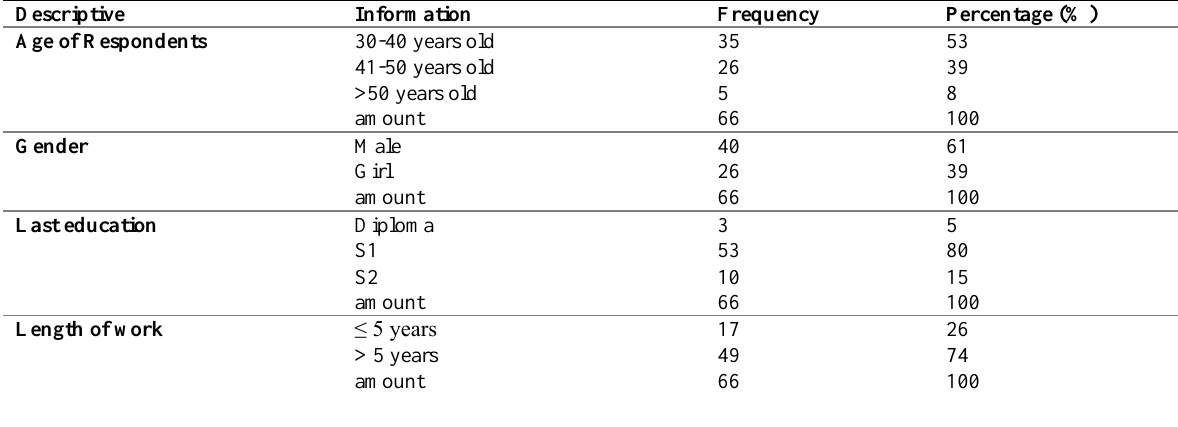
Table 3: Data Characteristics of